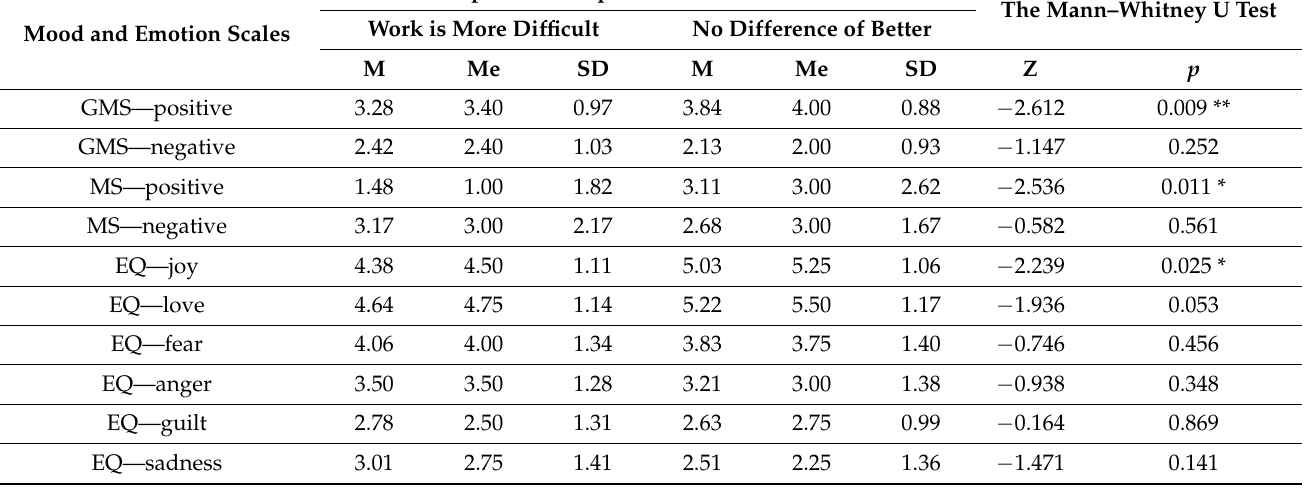
Table 7. Assessment of the impact of the COVID-19 pandemic on the work in the ward and the mood and